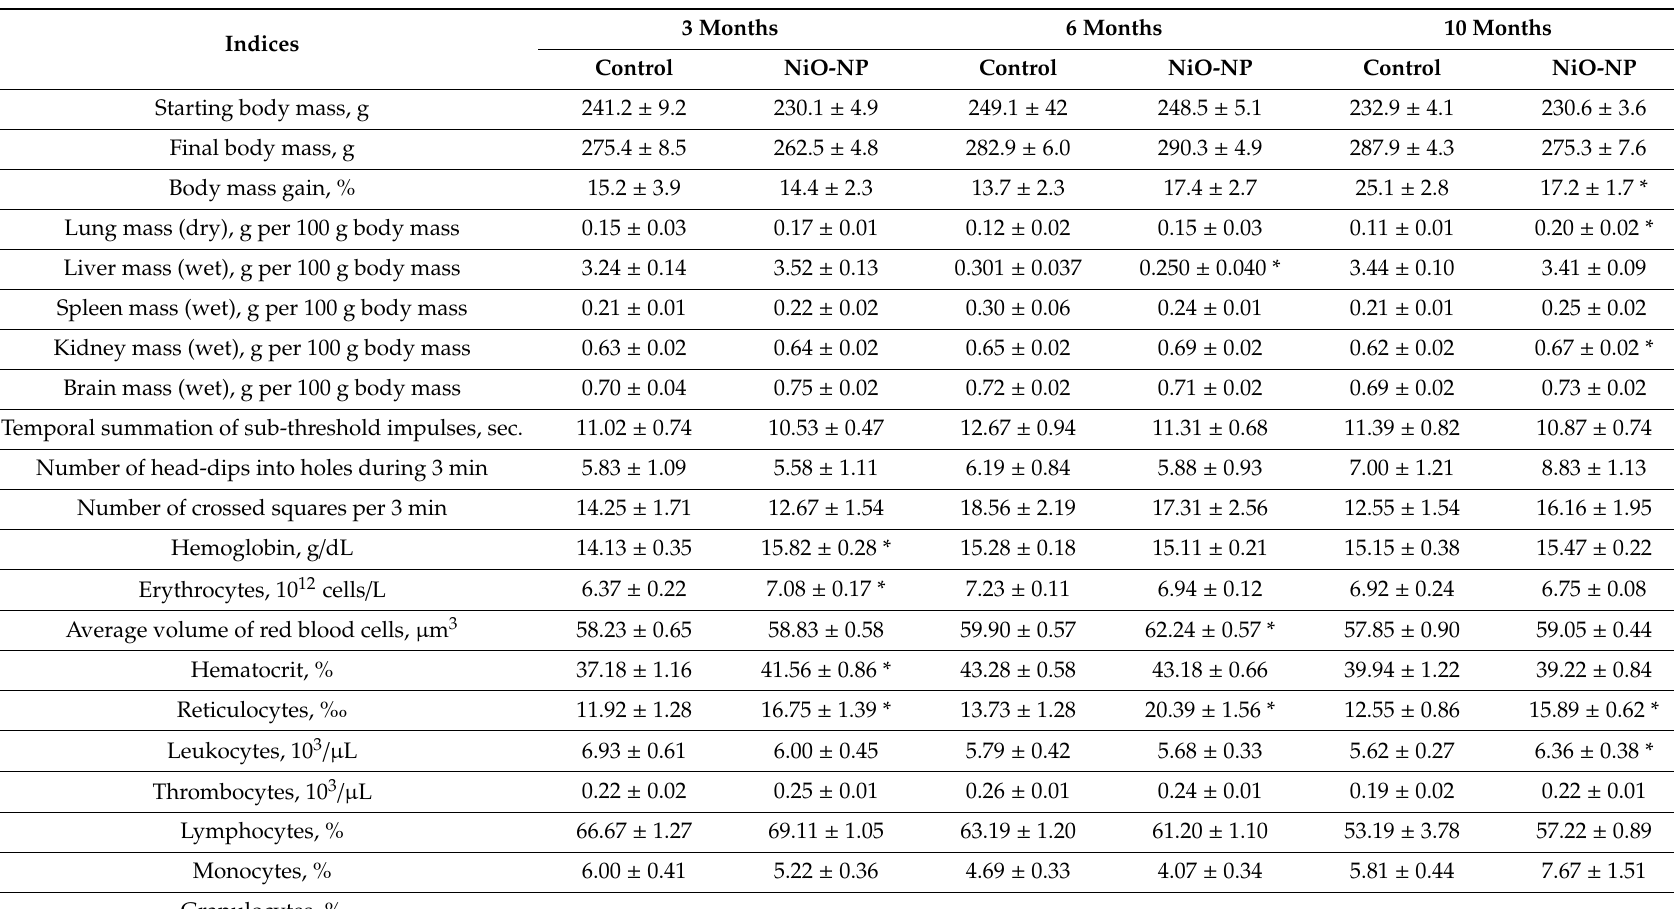
Table 6. Some functional indices for rat organism status 24 h after the last 4 h inhalation exposure to NiO-NPs at a 0.23 ± 0.01 mg / m 3 concentration repeated daily for 3, 6, or 10 months; mean results for at least 12 rats in exposed and sham-exposed groups of each term ( x ± s.e.